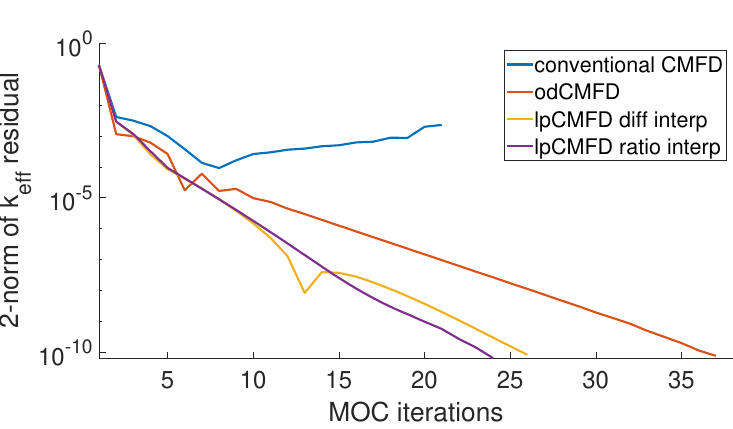
Figure 3: 2-norm of k residuals vs. MOC iterations, 2D C5G7 problem. eff